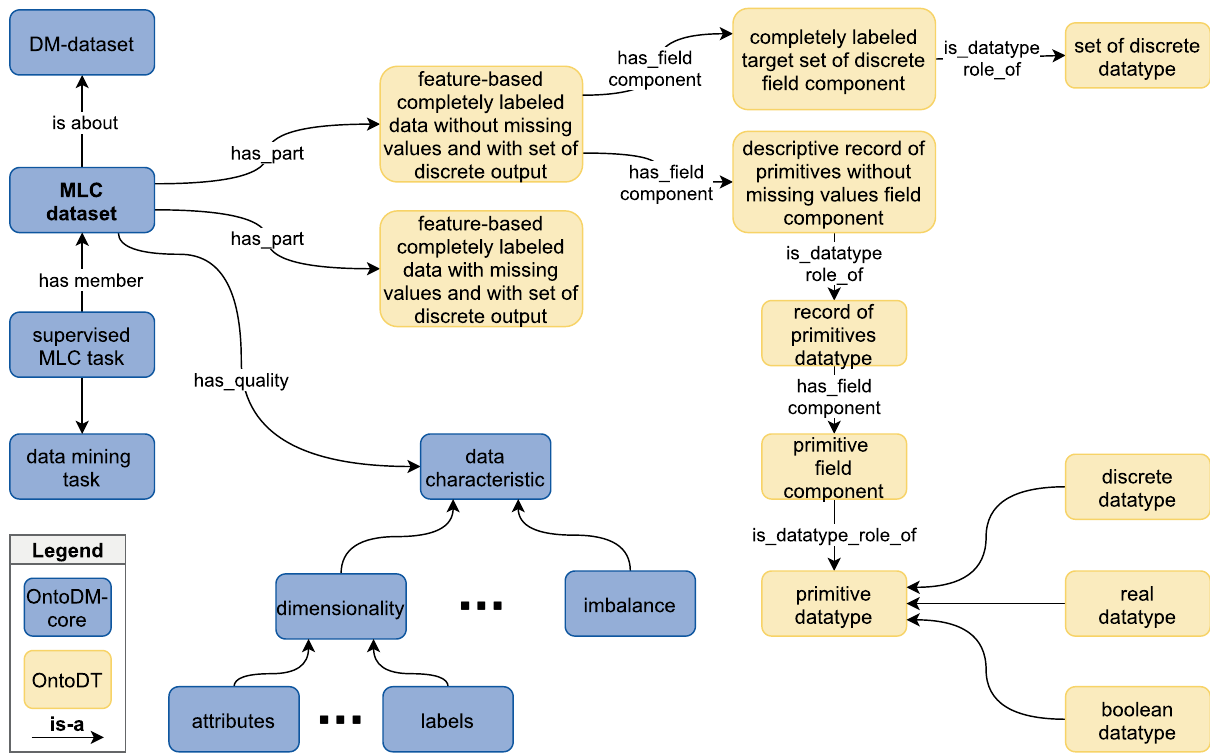
Figure 5. ML-specific annotation schema for MLC datasets based on the OntoDM-core 13 and OntoDT 14 ontologies. The schema allows annotation of the different datatypes appearing in the datasets, specification of the data mining task, and representing MLC-specific meta-features as data characteristics, which are connected with the MLC dataset via the has_quality